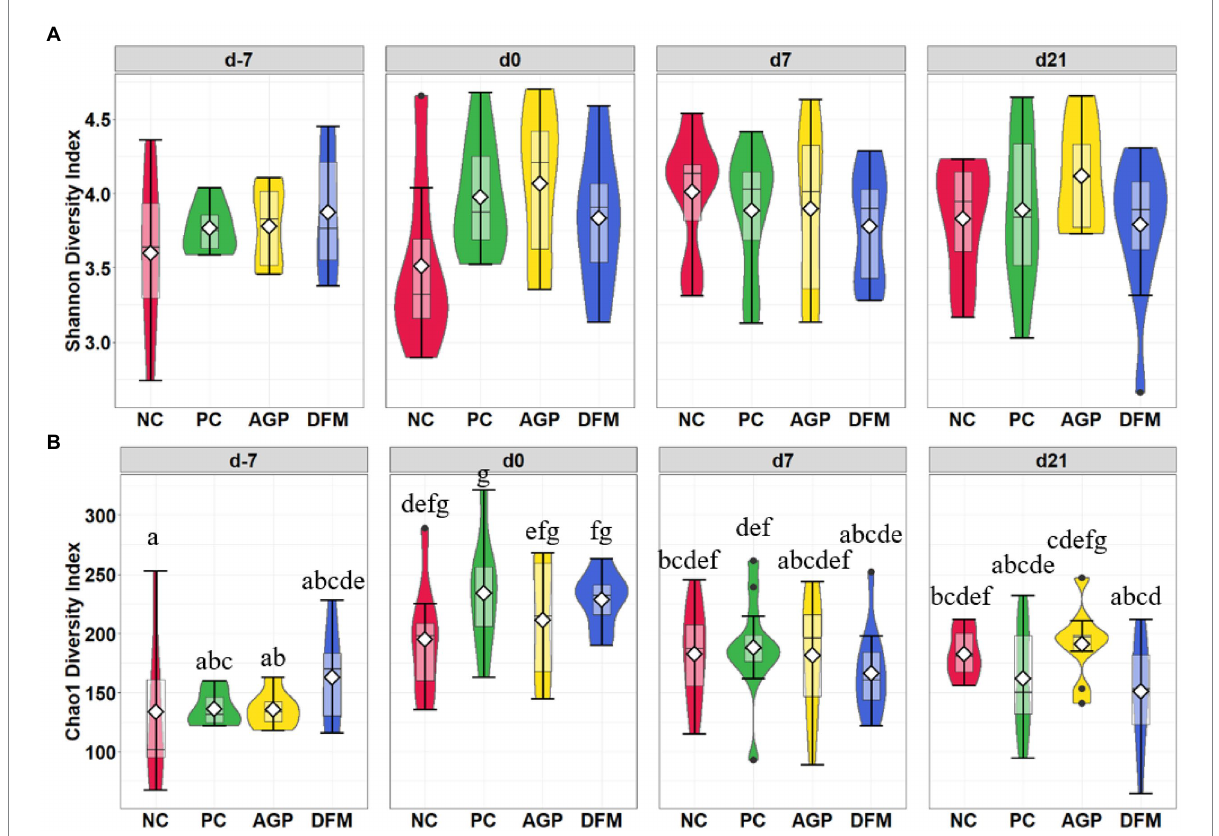
FIGURE 1 Alpha diversity as indicated by Shannon (A) and Chao1 (B) indices in feces collected from enterotoxigenic Escherichia coli challenged pigs fed diets supplemented with antibiotics (AGP) or Bacillus subtilis (DFM) at the beginning of the experiment, on day 0 before inoculation (day − 7), on day 7 and 21 post-inoculation. No difference was observed in Shannon (A) . NC = negative control, PC = positive control, AGP = antibiotics, DFM = B. subtilis . Violin plots are colored by diet. Data are expressed as mean (diamond) ± SEM. a-g Means without a common superscript are different ( p < 0.05). Each mean represents 7 observations on day − 7 and each mean represents 9–12 observations on day 0 and day 7 and 21 post-